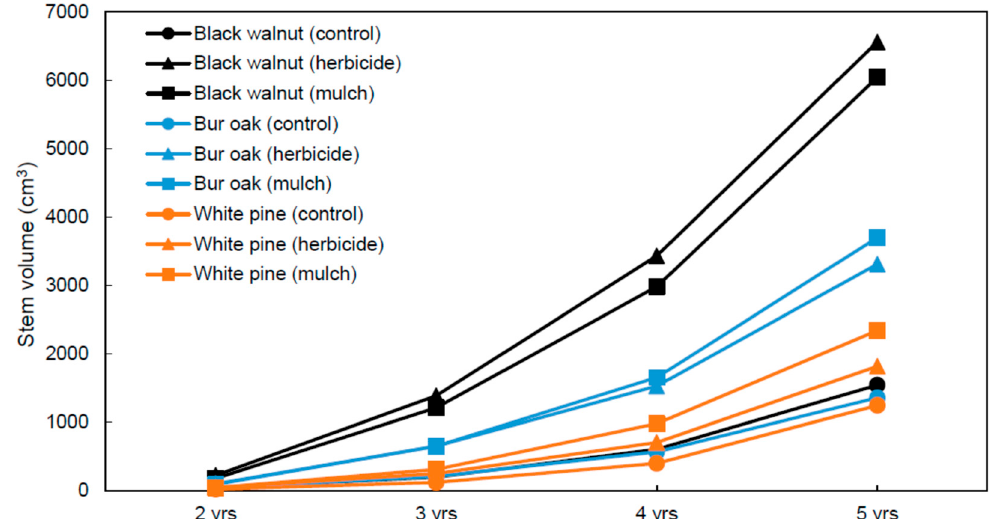
Figure 3. Species effect on survival rate ( p = 0.05) in an agricultural riparian buffer. Vertical bars represent standard error of the difference (SED).